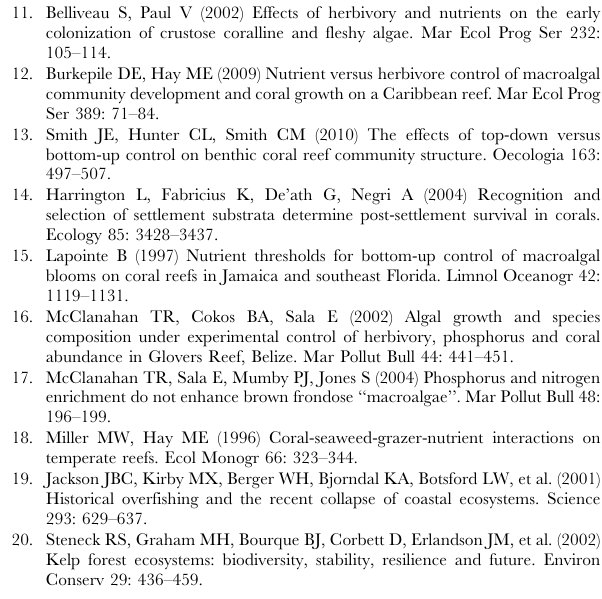
Figure S1 Study site. Right panel shows position of the study area in the Red Sea. The circle on the left panel indicates the study site at the Northern tip of Al Fahal-reef, located about 13 km off the Saudi-Arabian coast. Figure S2 Temperature development at Al Fahal reef. Daily average temperatures ( 6 max/min) of the 16 experimental frames at 5 m water depths at Al Fahal reef over the study period from June to September 2011. Sampling times are indicated by vertical lines.